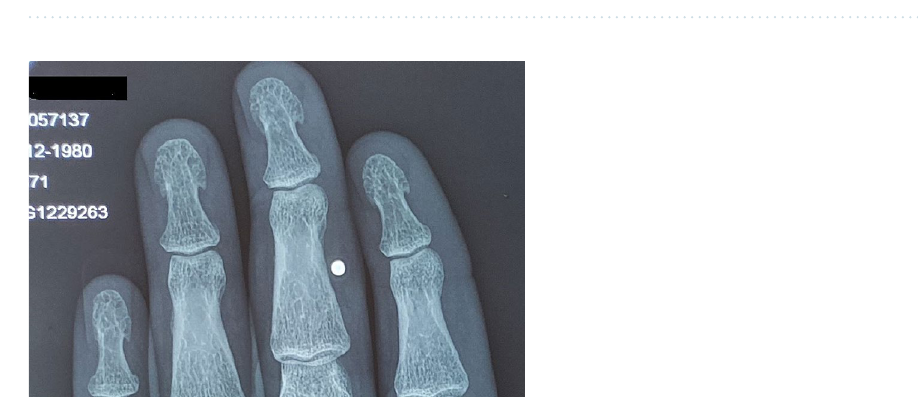
Figure 3. Zoom of previous Plain X ray hands PA view shows tuft spur-like excrescences mimicking that of (spade phalanx sign) of acromegaly.